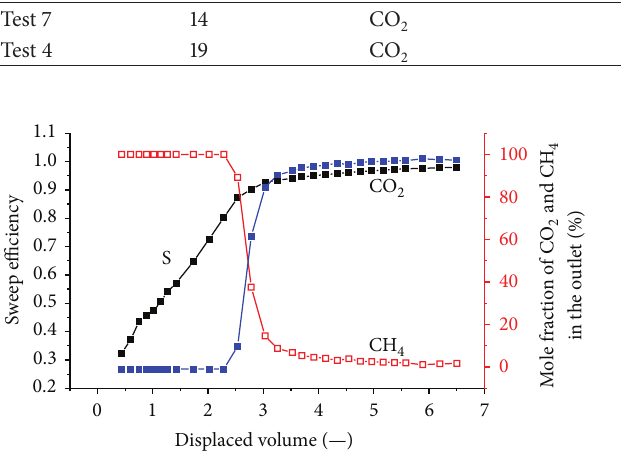
Figure 11: The sweep efficiency and concentrations of produced gas against displaced volume at 2.2